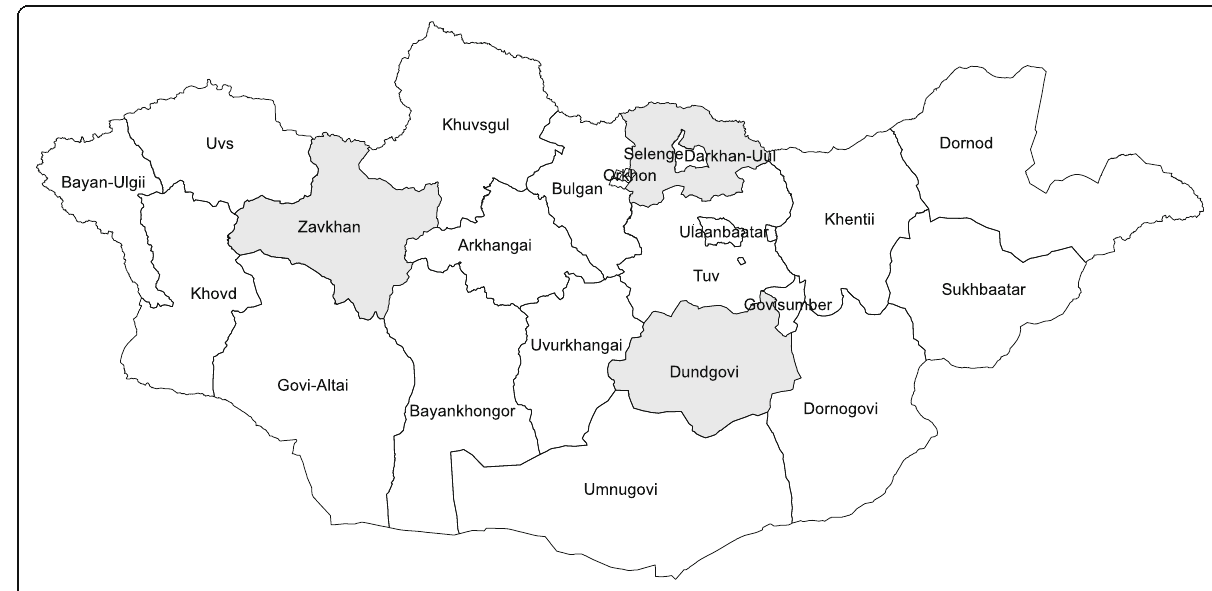
Fig. 1 Map of the rural Mongolian study provinces created by the authors using ArcGIS® ArcMap software by Esri (ESRI, CA,